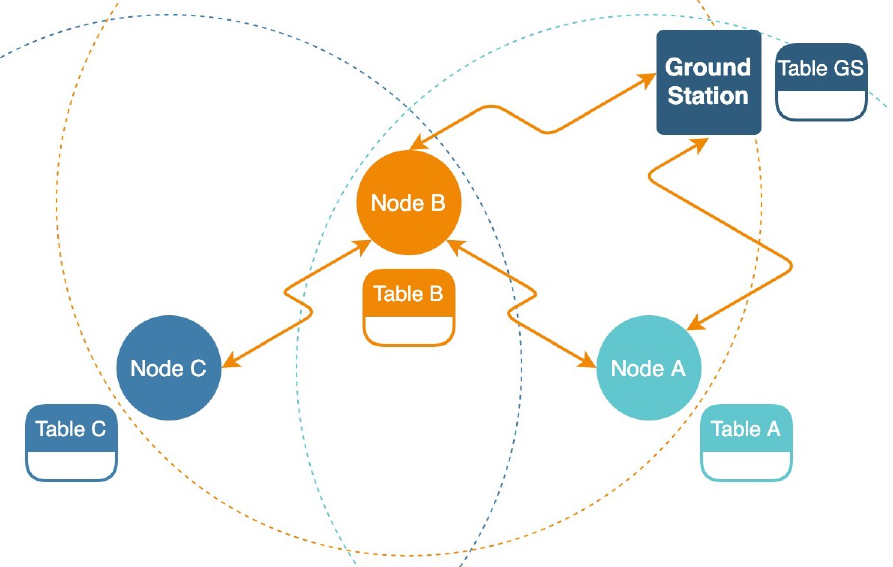
Figure 5. The wireless sensor network protocol diagram. Nodes A and B exchange information directly. Nodes A and C exchange information through Node B. The dotted rings represent the node’s transmit and receive